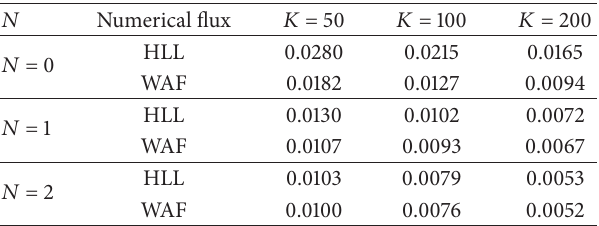
Table 1: RMS errors when 𝑁 = 0, 𝑁 = 1, and 𝑁 = 2.